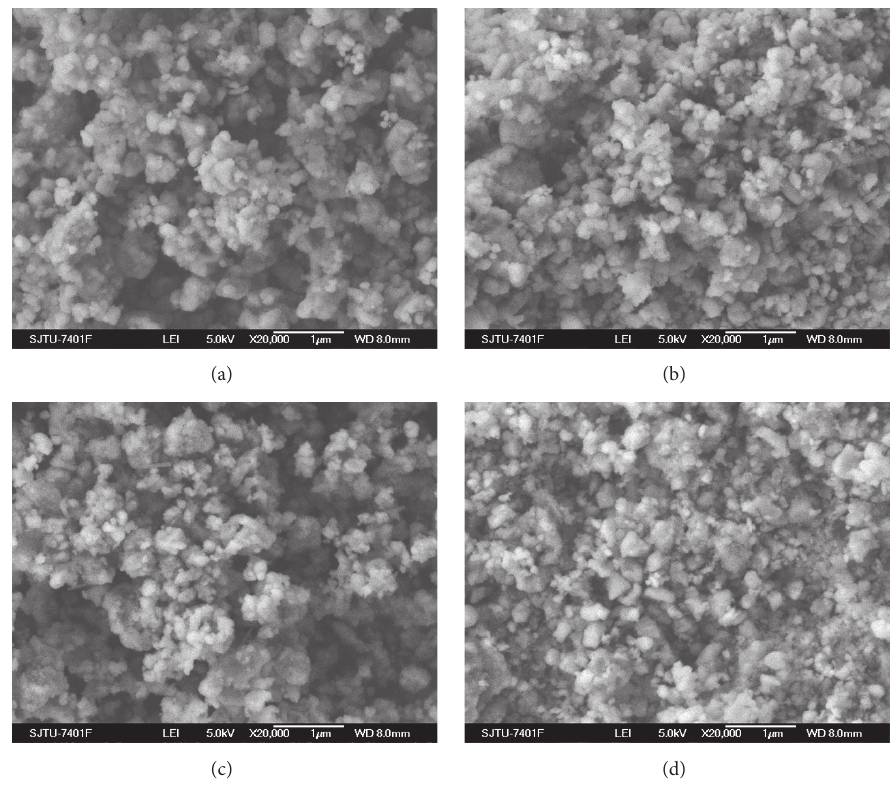
Figure 2: SEM images of LMP/C (a), 8LMP ⋅ LVP/C (b), 4LMP ⋅ LVP/C (c), and LVP/C (d)